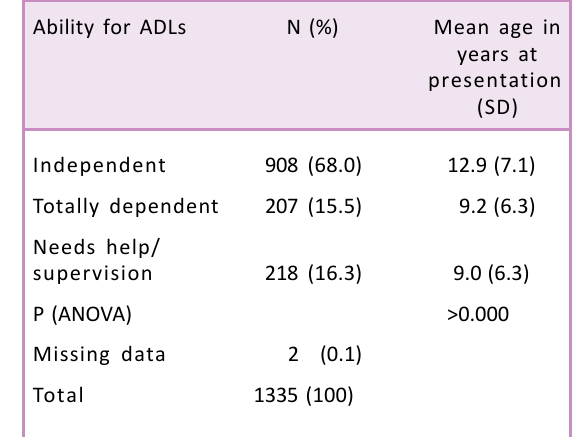
Table 1. The study population by the ability to engage